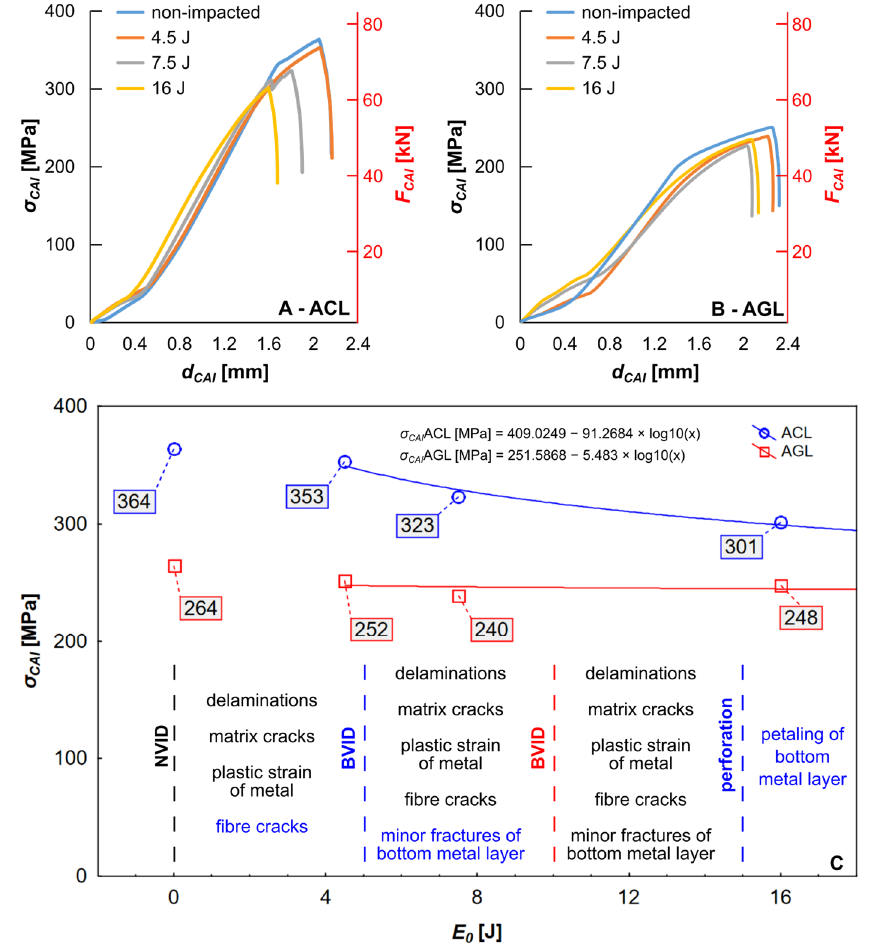
Figure 5. Force ( 𝐹 (cid:3004)(cid:3002)(cid:3010) )/strength ( σ (cid:2887)(cid:2885)(cid:2893) (cid:4667) –displacement ( 𝑑 (cid:3004)(cid:3002)(cid:3010) ) characteristics of tested FMLs under com- pression after impact (( A )—ACL, ( B )—AGL). The strength was correlated with the impact energy (cid:4666)E (cid:2868) (cid:4667) and damage forms recognized after low-velocity impact to present the in fl uence of impact con- dition on residual strength of FML ( C ).